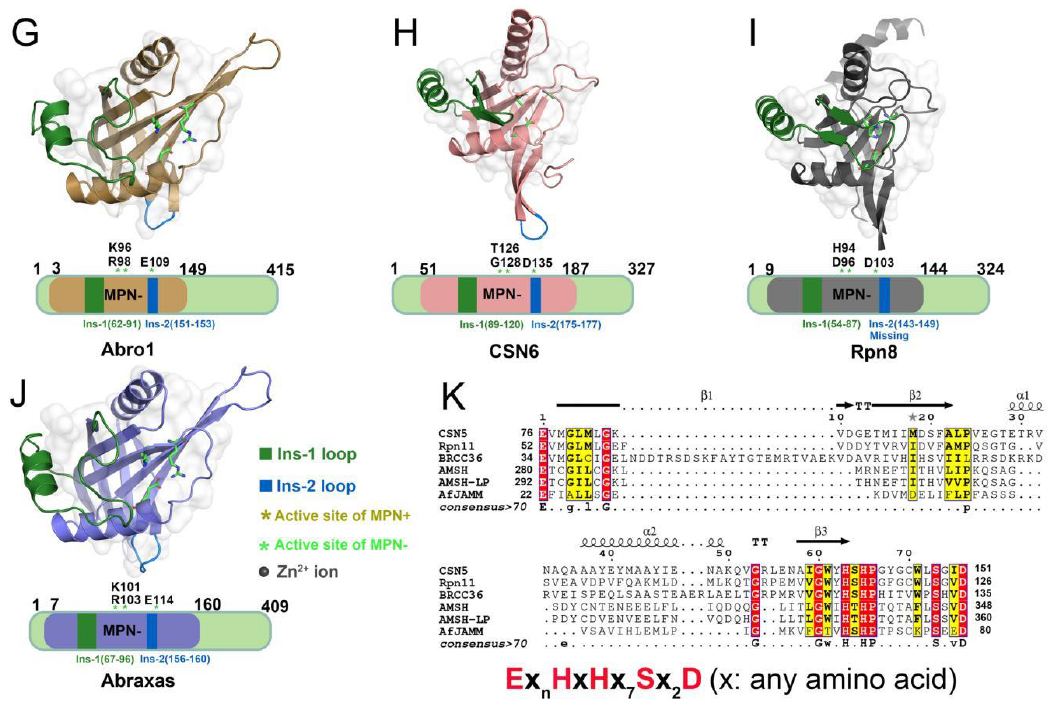
Figure 2. Structural characteristics of JAMM MPN domain mentioned in this review. ( A ) Crystal structure of AfJAMM (PDB ID: 1R5X). AfJAMM has a typical MPN domain containing an eight- stranded β sheet (β1–β8) (fuchsia), a long α helix (α1), and a short α helix (α2) (cyan). ( B – J ) Crystal structure of AMSH (PDB ID: 3RZU) (light blue), AMSH-LP (PDB ID: 2ZNV) (wheat), BRCC36 (PDB ID: 6H3C) (light pink), CSN5 (PDB ID: 4F7O) (pale cyan), Rpn11 (PDB ID: 4O8X) (gray), Abro1 (PDB ID: 6H3C) (sand), CSN6 (PDB ID: 4D10) (salmon), Rpn8 (PDB ID: 4O8X) (light black), and Abraxas (PDB ID: 6GVW) (slate) MPN domain. All the Ins-1 and Ins-2 loop are colored deep green and blue, respectively. The yellow and green asterisks represent active sites of MPN+ and MPN–, respectively. The black round represents Zn 2+ ion. ( K ) The zinc-coordinating JAMM motif of MPN+ (Ex n HxHx 7 Sx 2 D) (where x is any amino acid residue).